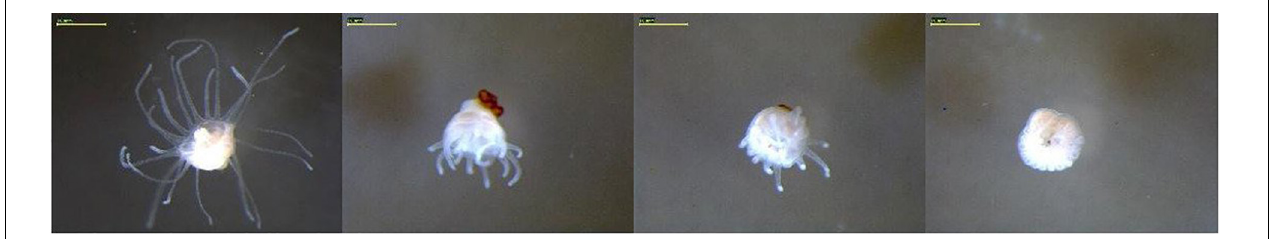
FIGURE 1 | Examples of response scores of Aurelia sp.1 polyps. Response to stimuli is in decreasing order from left to right 5-1. A response score of 5 indicates optimal polyp response; a response score of 1 indicates compromised tissue integrity (refer to Table 1 for a complete definition of response scores).